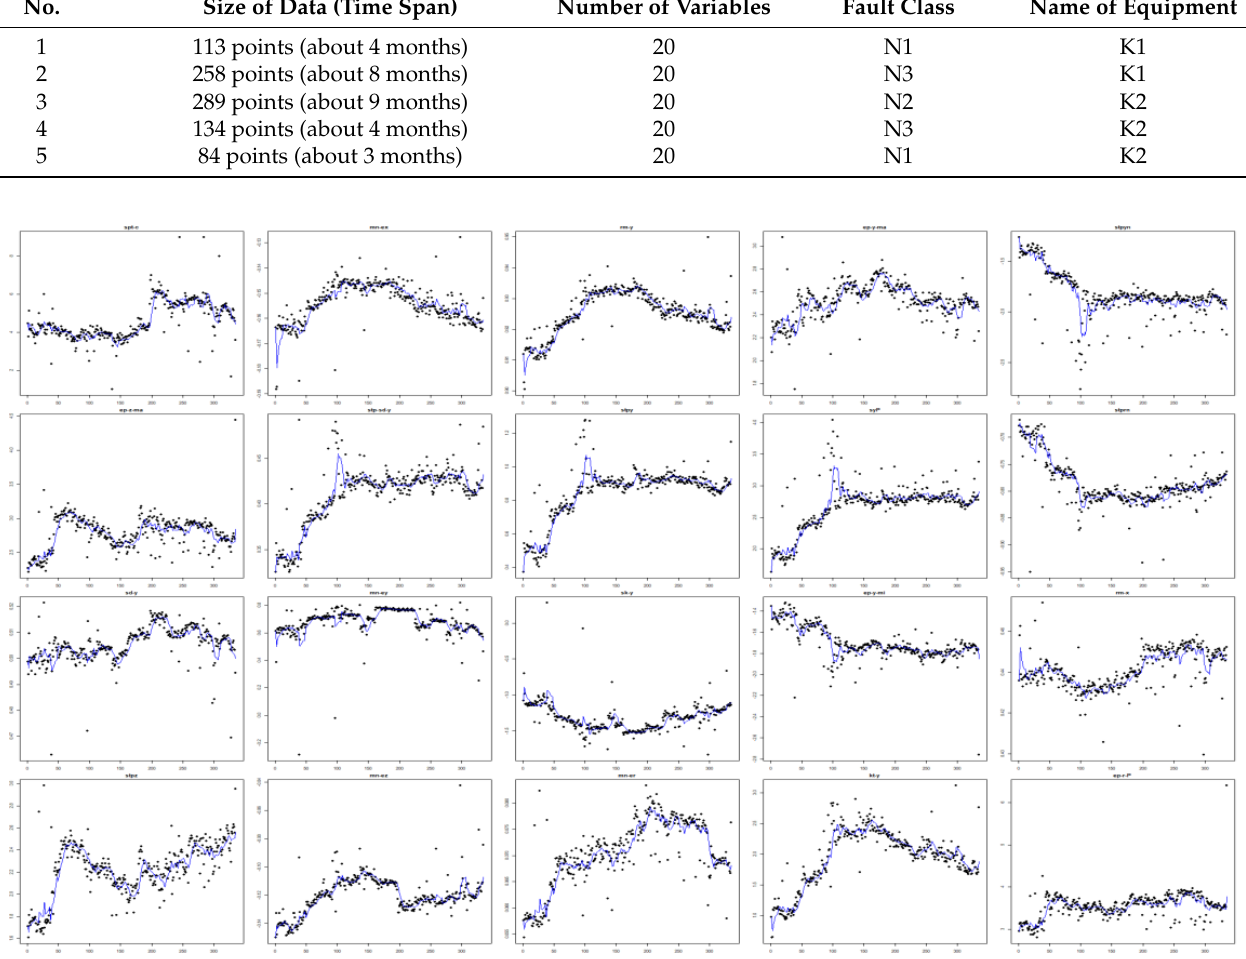
Figure 7. The variable plot of robot arm data. Table 1. The details of robot arm data.